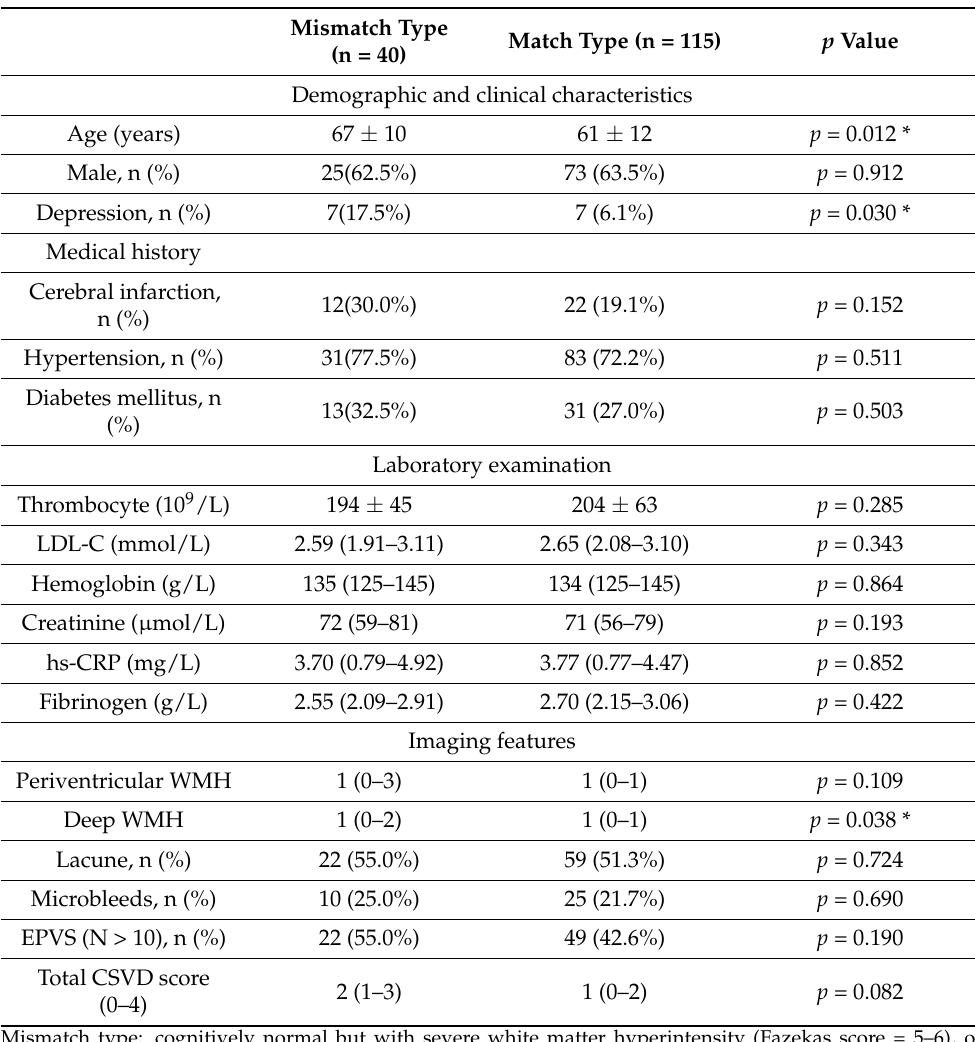
Table 3. Comparison between mismatch and match types.